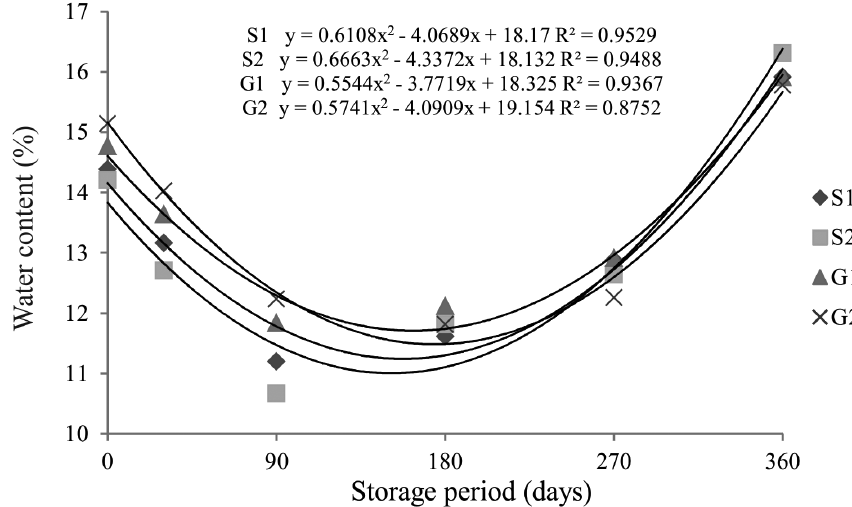
Figure 2 - Signi fi cant regression model to water content data of beans seeds (S1 and S2) and grains (G1 e G2), of variety BRS Splendor, during storage periods. Cascavel,